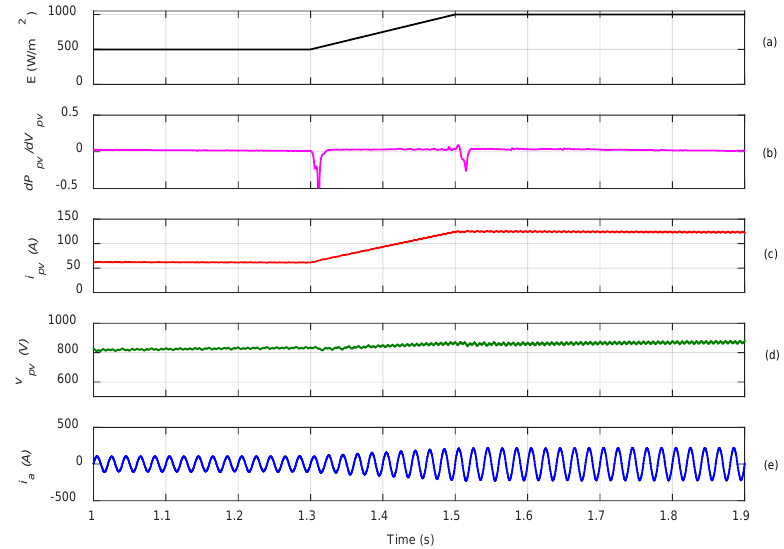
Figure 10. Irradiance ramp increase: ( a ) irradiance, ( b ) power derivative, ( c ) photovoltaic current. ( d ) photovoltaic voltage, and ( e ) grid current, in case of proposed RCC-MPPT algorithm.